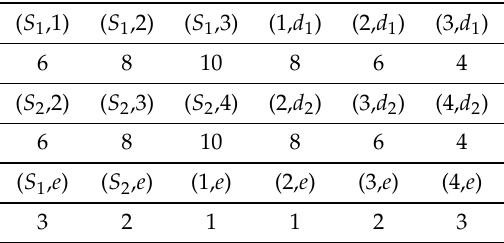
Table 2. Mean Channel Gain.